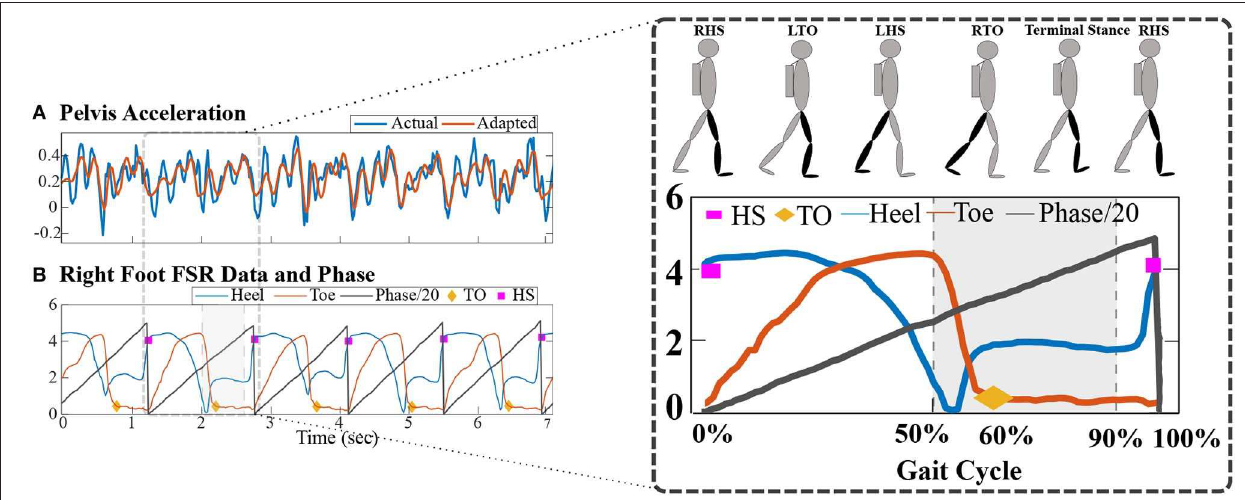
FIGURE 2 | (A) Desired vertical pelvic acceleration and adapted pelvic acceleration profiles during a walking trial. (B) FSRs data from right foot with Heel-Strike (HS) and Toe-Off (TO) events. Gait phase values in percentages are calculated using Algorithm 1 and gait events. The shaded gray region shows the 50–90% of a gait cycle during which WeARS applied the force intervention.